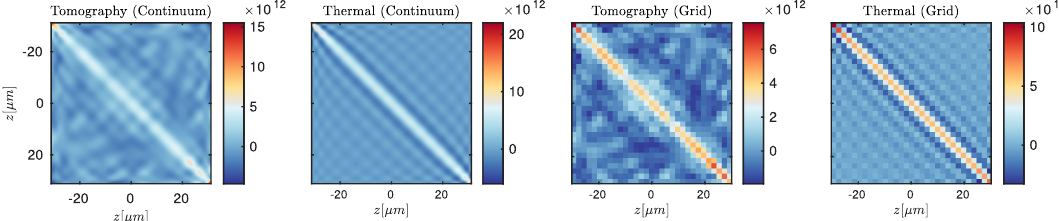
Figure 22: The real space representation of the reconstructed density fluctuation covariance matrix for the same experimental scan as in Fig. 8 but based on eigen-modes. We see a much more pronounced localization in coordinate space since the inclusion of higher momentum modes allows us to observe more short- range structures. Most notably in comparison to anti-correlation stripes close to the